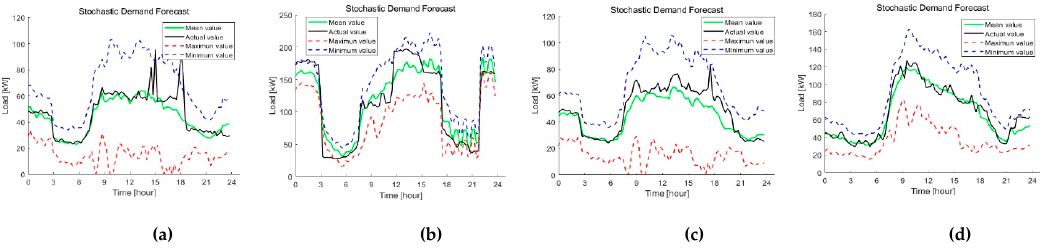
(d) Figure 16. KEPRI stochastic demand forecast. ( a ) Spring, ( b ) Summer, ( c ) Fall, ( d ) Winter.